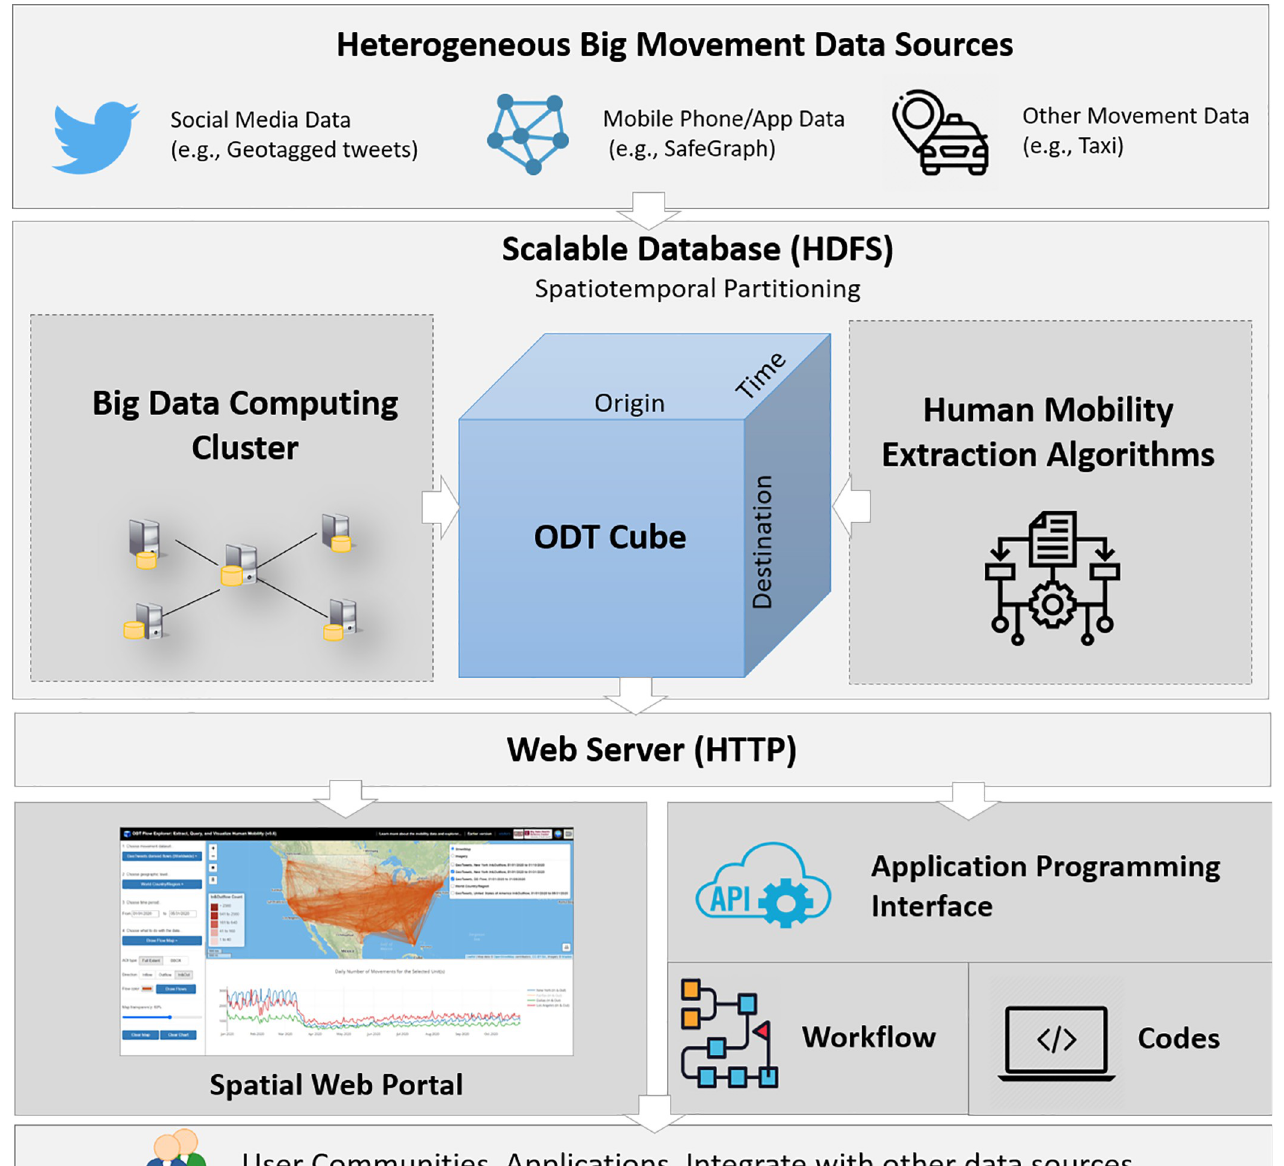
Fig 1. System architecture of the ODT Flow